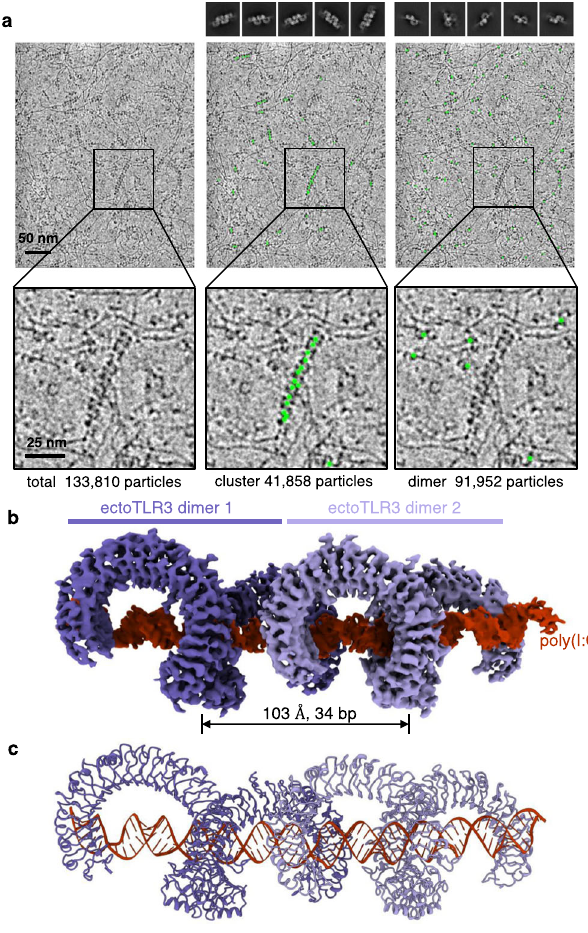
Fig. 2|Cryo-EMstructureoftheectodomain ofTLR3incomplexwithpoly(I:C) RNA.a RepresentativemicrographicimageoftheectoTLR3-poly(I:C)complex.The picked particles in the cluster (middle) and the dimeric states (right) are marked with green circles. Representative 2D class averages are shown above. b Electron density map of the ectoTLR3-poly(I:C) complex. c The atomic model of the ectoTLR3-poly(I:C) complex. Representative micrograph is from an n =1087 cryo- EM experiment